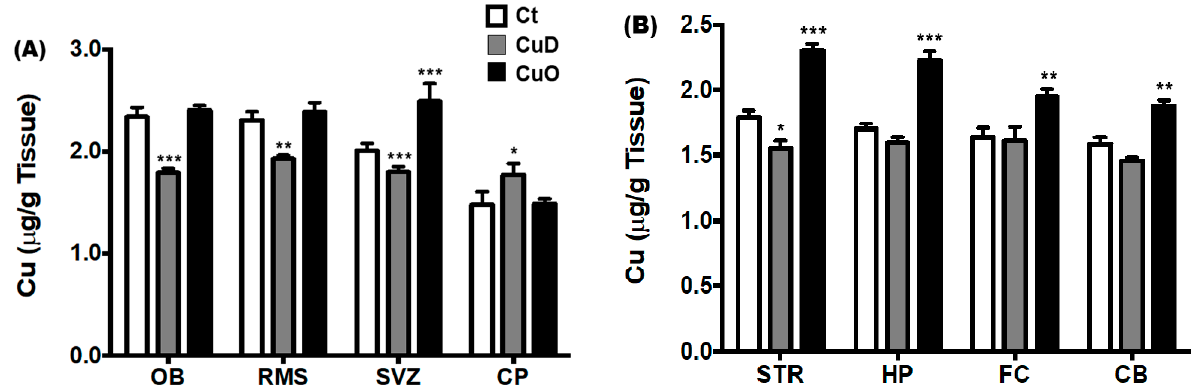
Figure 3. Brain regional Cu concentrations following CuD or CuO treatment. Brain tissues were dissected and analyzed for Cu by AAS. Data represents mean ± SEM, n = 6–7/group. *: p < 0.05, **: p < 0.01, ***: p < 0.001, as compared to the correspondent Ct group, using one-way ANOVA analysis. ( A ). Cu levels in the SVZ-RMS-OB axis and choroid plexus. ( B ). Cu levels in selected brain regions. Ct: control; CuD: Cu deficiency; CuO: Cu overload; CSF: cerebrospinal fluid; OB: olfactory bulb; RMS: rostral migratory stream; SVZ: subventricular zone; CP: choroid plexus; STR: striatum; HP: hippocampus; FC: frontal cortex; CB: